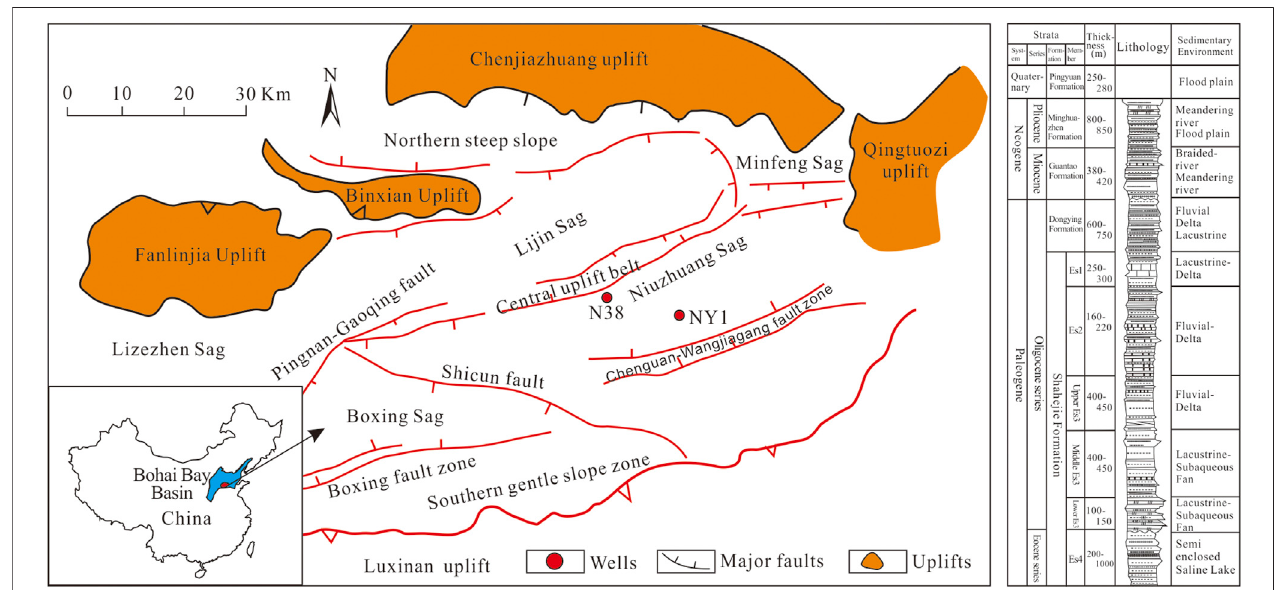
FIGURE 1 | Location, structural map and stratigraphic column of the Dongying Sag, modi fi ed after Zeng et al., 2017.